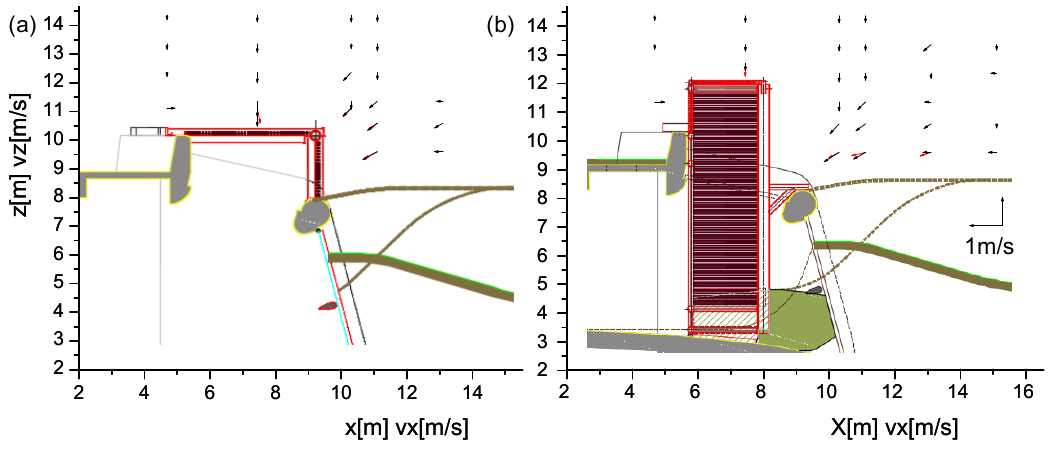
Figure 6. Comparison of the measurement (black arrows) and numerical simulations (red arrows) with a velocity ≥ 0.3 m · s − 1 in the symmetry plane of the intake structure—build-on model E 01 ( a ) and triangle option E 02 ( b )—intake discharge Q = 60 m 3 · s − 1